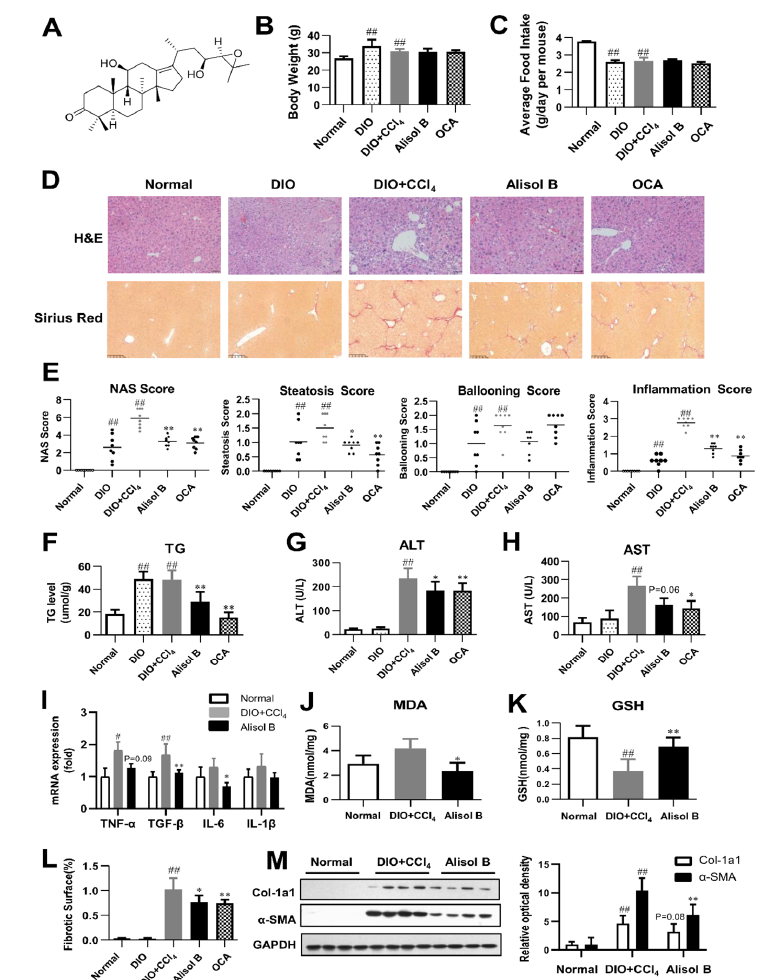
Figure 1. Alisol B ameliorated NASH in a DIO+CCl 4 -induced murine model. ( A ) The chemical structure of Alisol B. The therapeutic effects of Alisol B (100 mg/kg, once daily, p.o.) were evaluated in DIO+CCl 4 - induced mice as described in the Materials and Methods. ( B ) Body weight and ( C ) average food intake were measured. ( D ) H&E staining (200× magnification) and Sirius Red staining (100× magnification) were performed. ( E ) NAS score, steatosis score, ballooning score, and inflammation score were quantified. ( F ) Liver TG, ( G ) serum ALT and ( H ) AST, ( I ) hepatic mRNA levels of inflammatory cytokines, ( J ) hepatic MDA, and ( K ) GSH levels were measured. ( L ) Percentage of collagen deposition was calculated. ( M ) Western blot analysis of hepatic α -SMA and Col-1a1 expression was conducted and quantified. Data are presented as the mean ± SD, n = 8. # p < 0.05, ## p < 0.01 compared with the normal control group; * p < 0.05, ** p < 0.01 compared with the DIO+CCl 4 group.